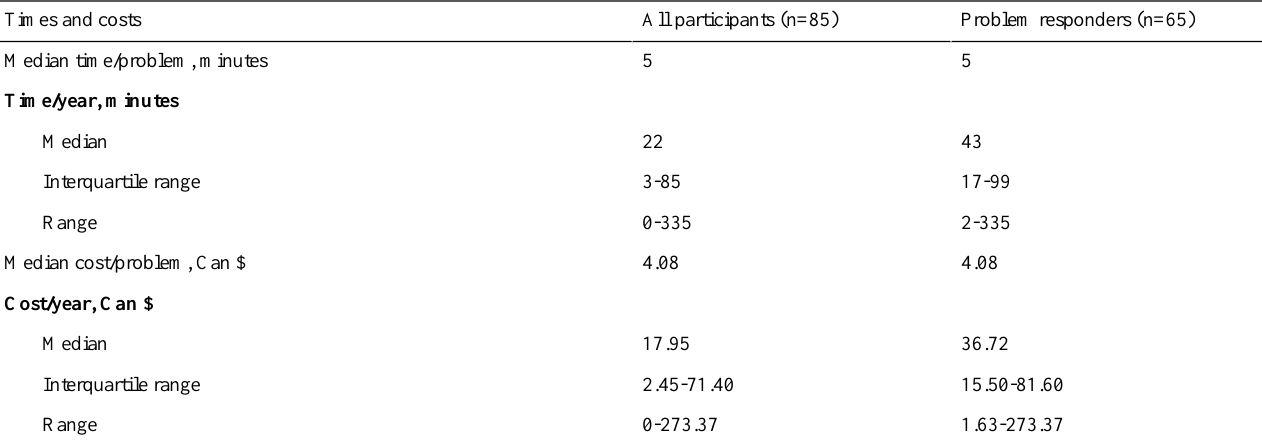
Table 2. Median time and cost per problem and per year for all participants and problem responders during WelTel